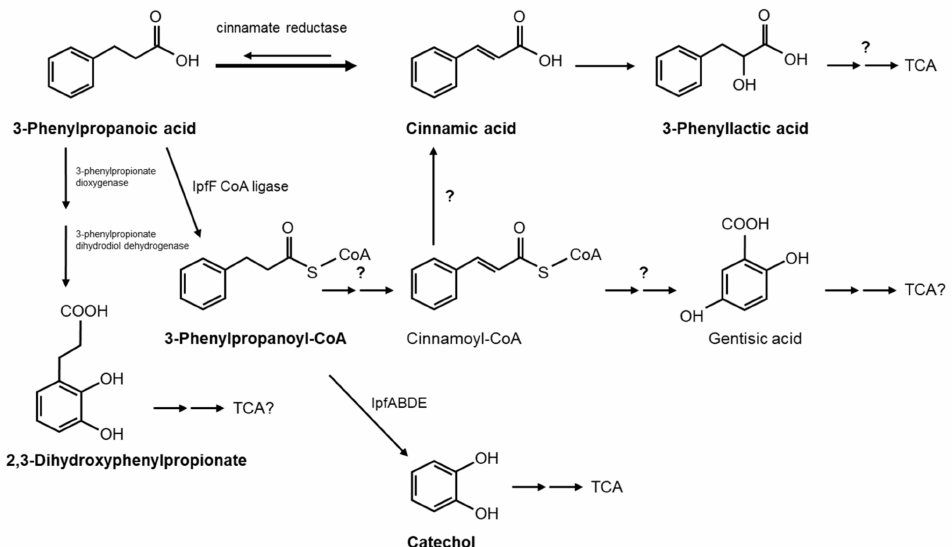
Figure 3. Possible degradation pathways of 3PPA by S. granuli RW412. The compounds identified in this study, which were 3PPA, cinnamic acid, phenyllactic acid, 3-phenylpropanoyl-CoA, 2,3- dihydroxyphenylpropionate, and catechol are indicated in